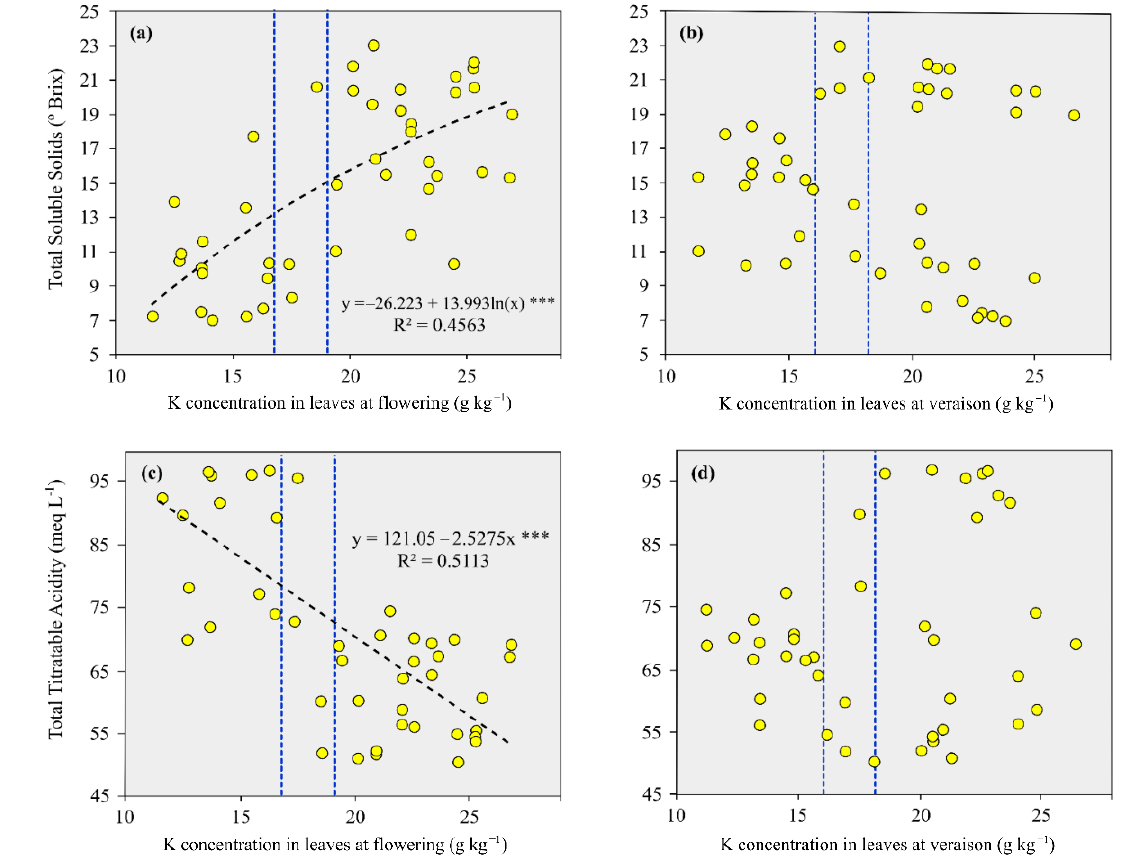
Figure 5. The relationship between the total soluble solids (TSS) and the K concentration in leaves ( a , b ) and between the total titratable acidity (TTA) and the K concentration in the leaves ( c , d ) at flowering and veraison, in 2016/17, 2017/18 and 2018/19, in ‘Pinot Noir’ submitted to soil applied K fertilizations. Vertical blue dotted lines represent the range of probability of occurrence (95% highest density interval) of the CL of K. Black dotted lines show the behavior of the equation (TSS and TTA variables). “***” Significant at 0.1% ( p < 0.001).